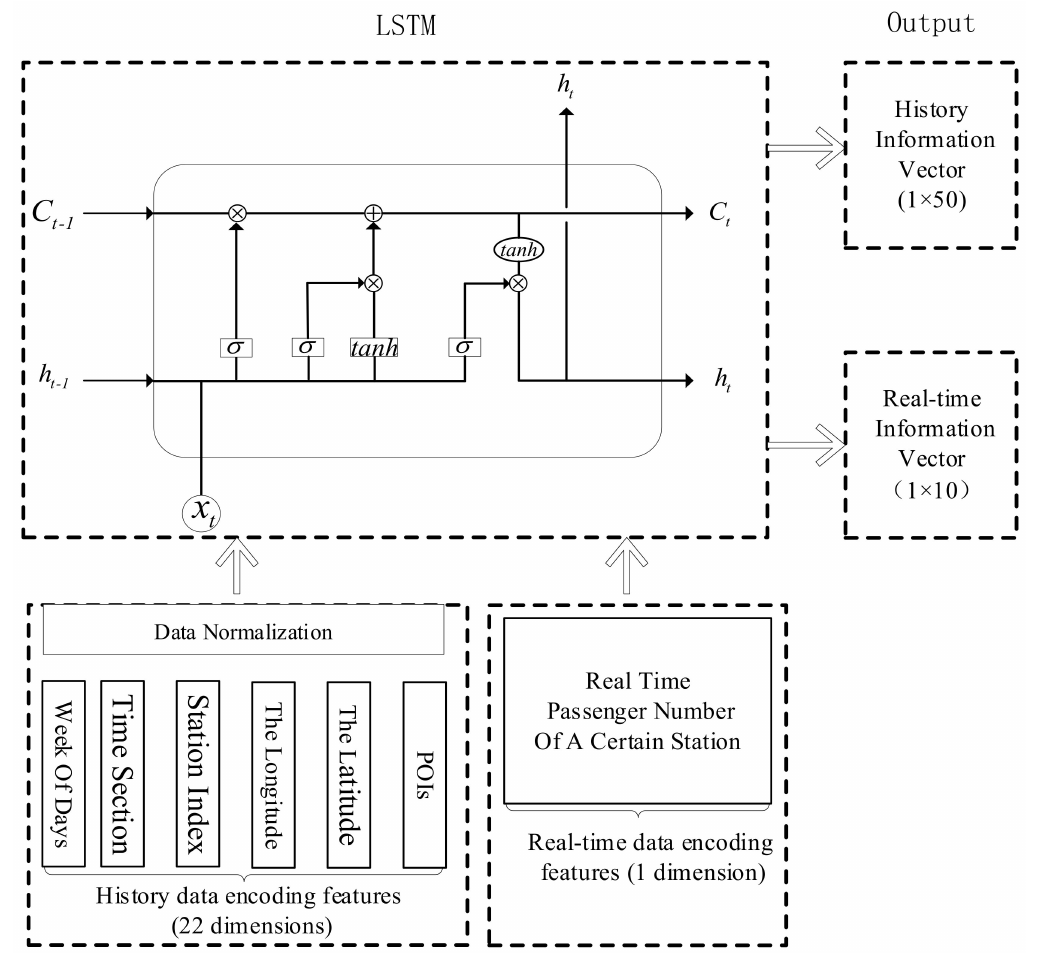
Figure 4. The process of the history and real-time data encoding.